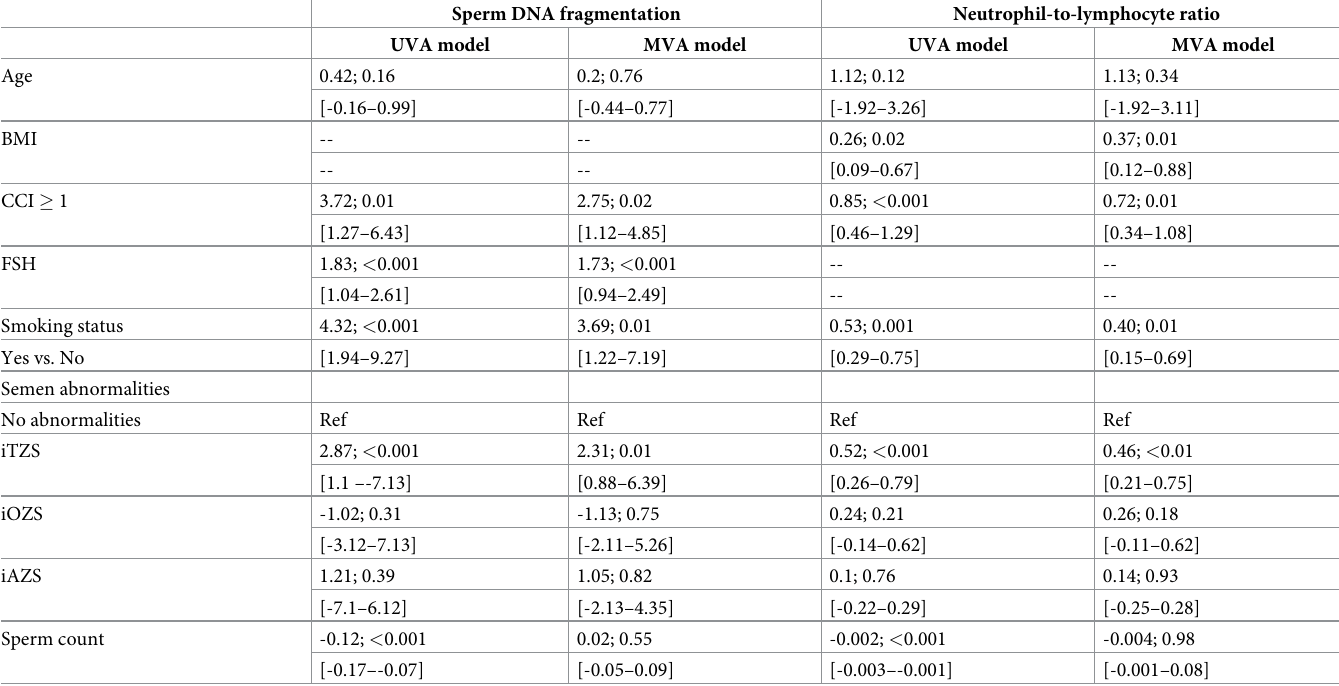
Table 3. Linear regression models predicting SDF and NLR (beta; p value [95%CI]) in infertile